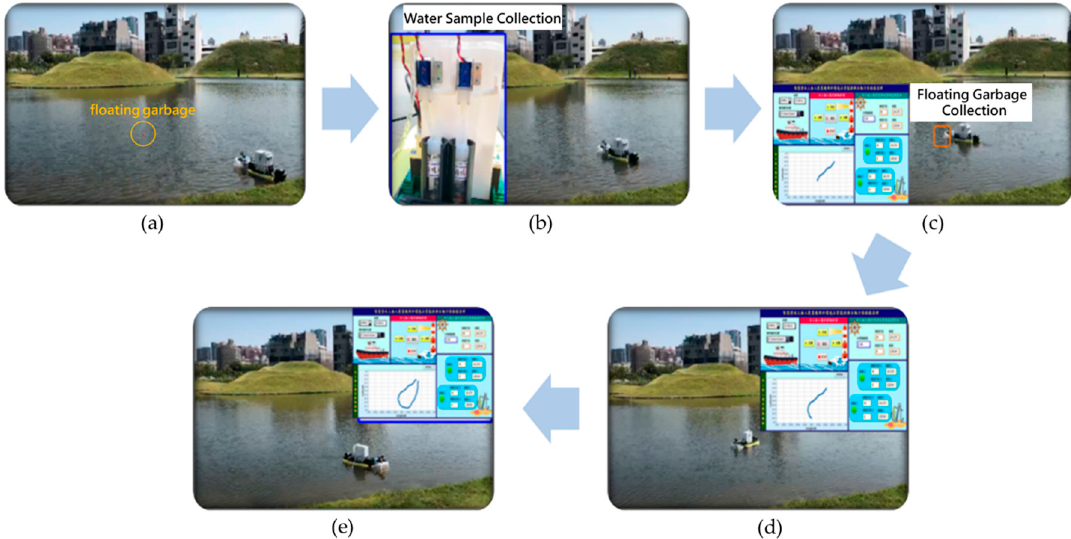
Figure 20. Experimental results for the multi-function tasks of the MF-USV. ( a ) The MF-USV sailed on the lake automatically and executed the obstacle avoidance task. ( b ) When the quality of water was abnormal, the MF-USV could collect the water sample in the water bottle. ( c ) When the floating garbage was detected, the MF-USV could collect and clean the floating garbage. ( d ) The MF-USV executed the obstacle avoidance task. ( e ) The MF-USV returned to the initial location automatically.